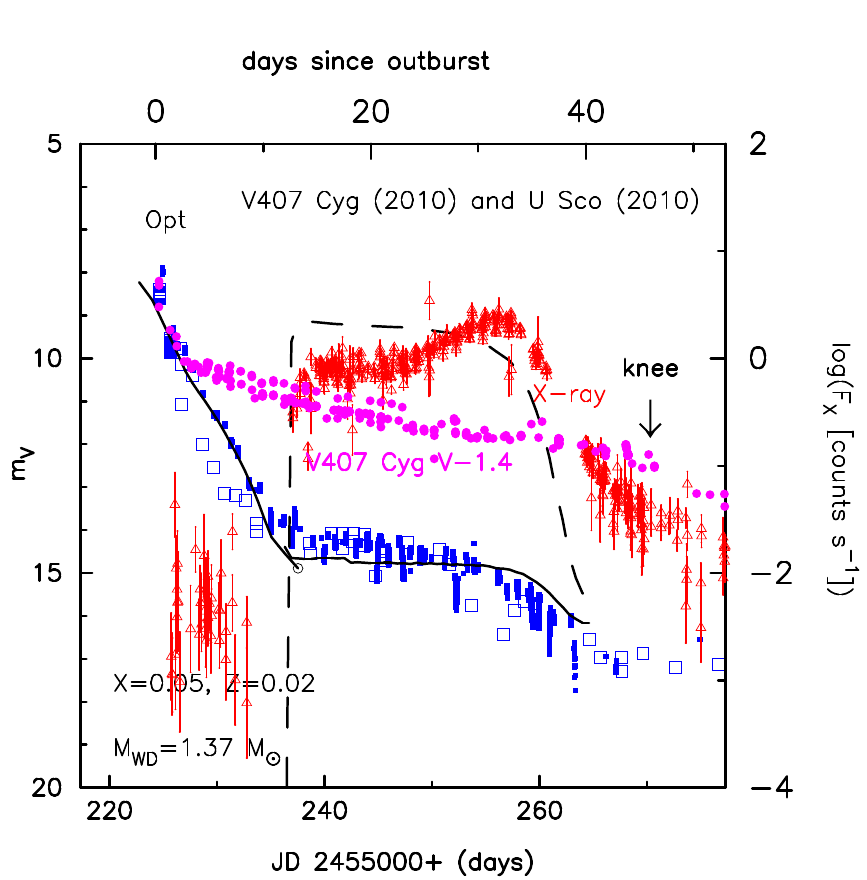
Fig. 4. Same as in Fig. 3, but for U Sco 2010 together with V407 Cyg 2010 outburst. Magenta (cid:12)lled circles : V magnitudes of V407 Cyg taken from Munari et al. (2011), IAU Circulars, VSOLJ and AAVSO archives. Blue open squares : y magnitudes of U Sco 2010 outburst taken from VSOLJ archive. Blue (cid:12)lled small squares : V -magnitudes of U Sco 2010 outburst taken from AAVSO archive. Red open triangles with error bars : X-ray count rates of the Swift XRT observations in the 0 : 3 (cid:0) 10 keV energy range with a time-interval of 1000 s taken from HEASARC. A black dashed line : model X-ray fluxes for M WD = 1 : 37 M ⊙ plotted against days after the optical peak (on JD 2455224.7, i.e., 2010 January 28.2 UT). A black solid line: a model V light curve calculated from a combination of free-free emission of optically thin plasma outside the photosphere and blackbody emission of the photosphere (WD + MS companion + Disk). We assume a WD mass of M WD = 1 : 37 M ⊙ and a uniform chemical composition of the envelope ( X = 0 : 05). A downward arrow: the epoch where the final decline of V407 Cyg started is indicated by an arrow denoted by